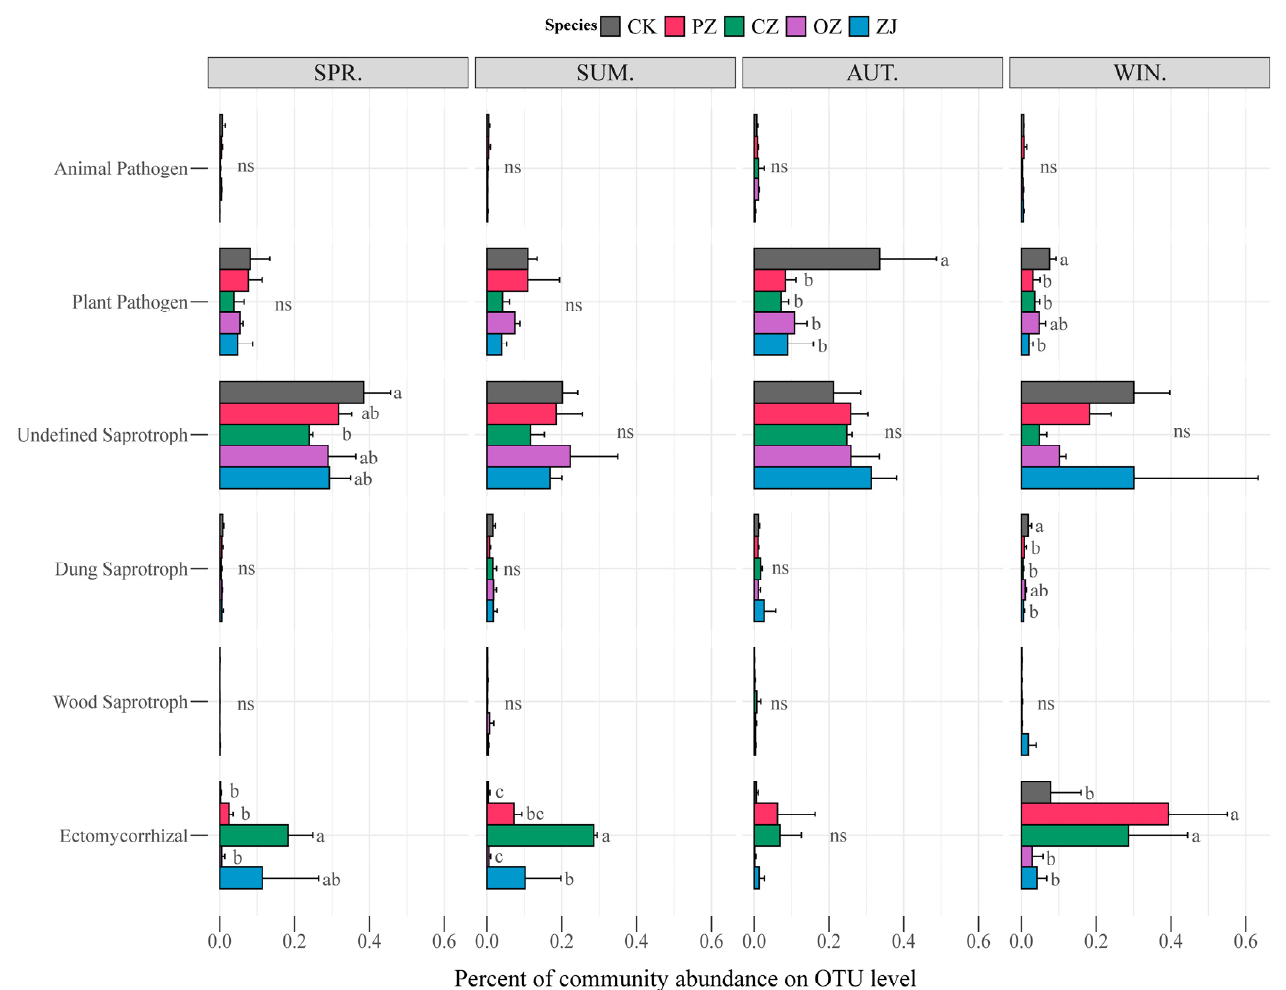
Figure 5. Functional features of fungal communities in four species of the genus Corylus in different seasons. CK: control; PZ: C . heterophylla ; CZ: C . kweichowensis ; OZ: C . avellane ; ZJ: C . heterophylla × C . avellane ; spr: spring; sum: summer; aut: autumn; win: winter. Different letters (a,b) indicate the significance level at p < 0.05, ns indicate no significance ( p >